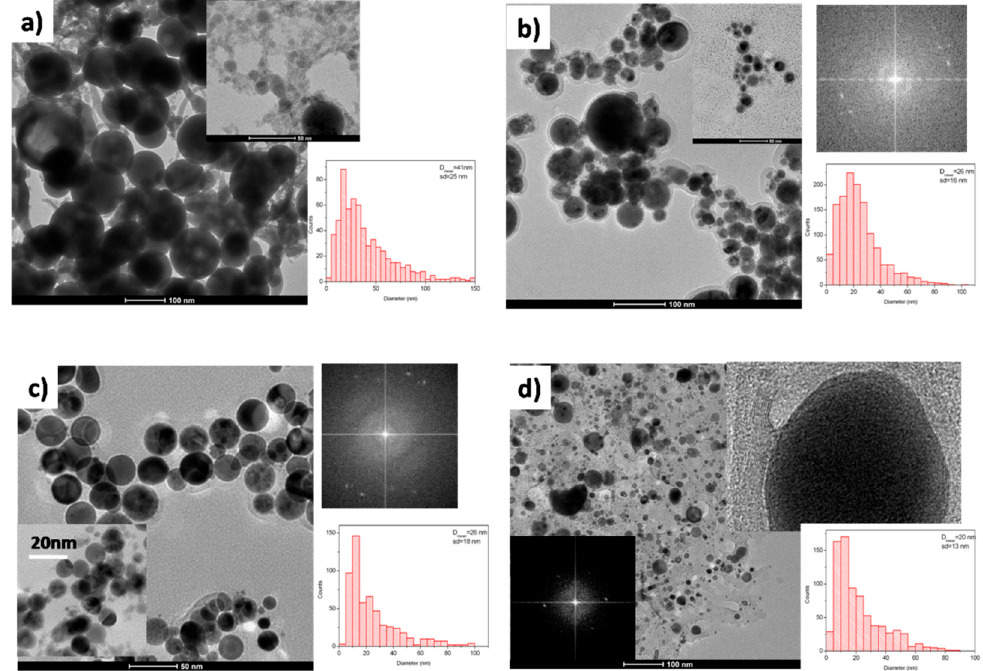
Figure 1. TEM images and particles size distributions of nanoparticles obtained by laser ablation of Ta in water ( a ), ethanol ( b ), acetone ( c ) and toluene ( d ).